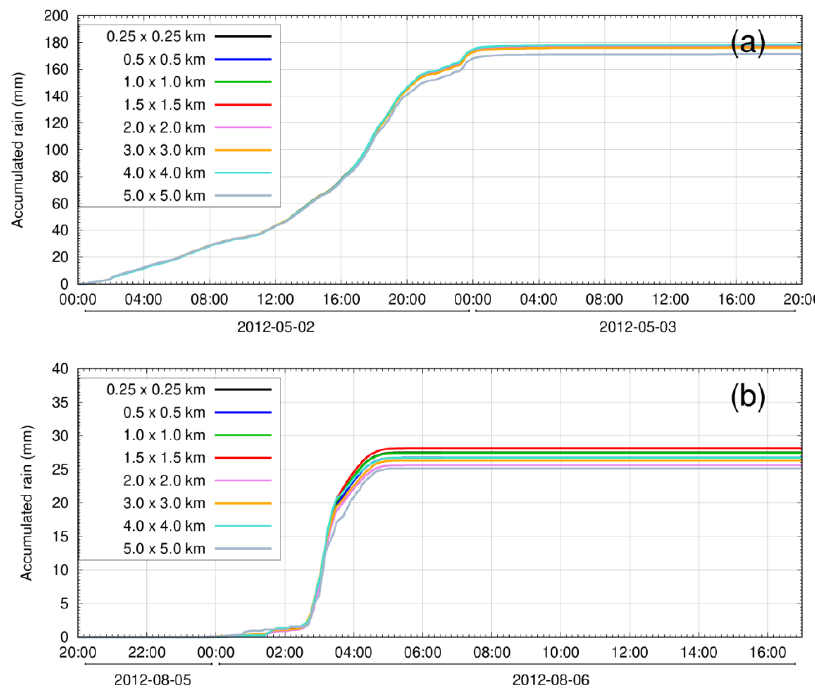
Figure 8. Basin-averaged accumulated rainfall profile for the different spatial resolutions for the event of ( a ) 2–3 May 2012 (widespread rain, WR) and ( b ) 5–6 August 2012 (convective rain, CR).